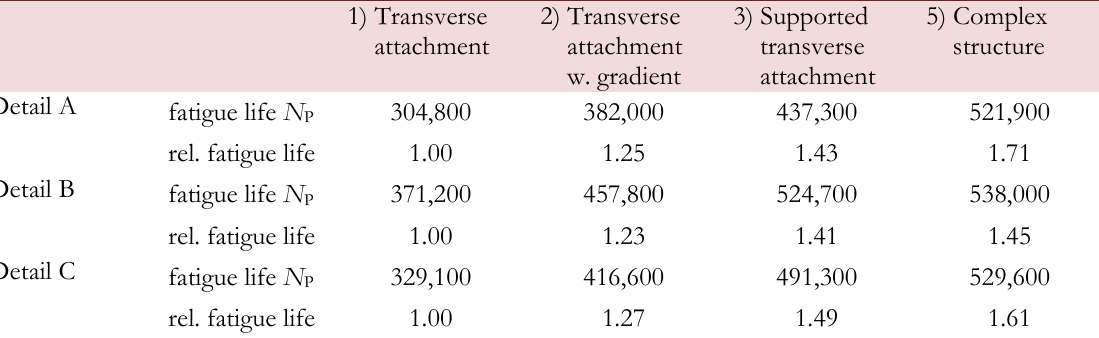
Table 6: Computed fatigue life N p for the same structural HSS σ s = 176 MPa at three sloped